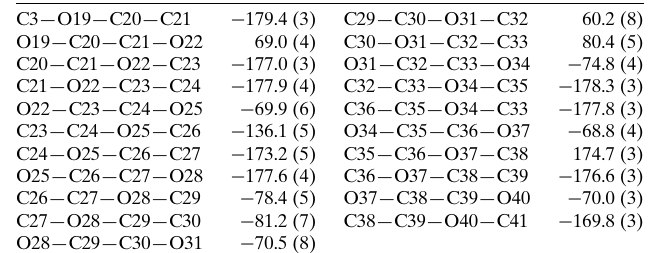
Table 2 Hydrogen-bond geometry (A˚ , (cid:4)